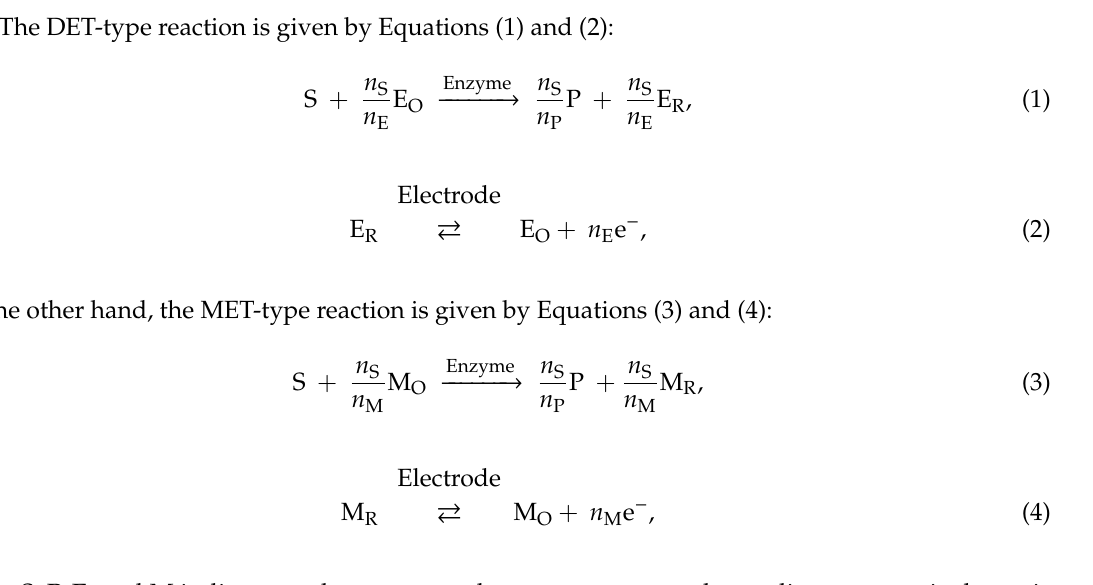
Figure 1. Schematic of electron transfer processes in direct electron transfer (DET)- and mediated electron transfer (MET)-type bioelectrocatalysis for substrate oxidation. In this scheme, the enzyme is assumed to have both catalytic and electron-donating sites in the molecules.